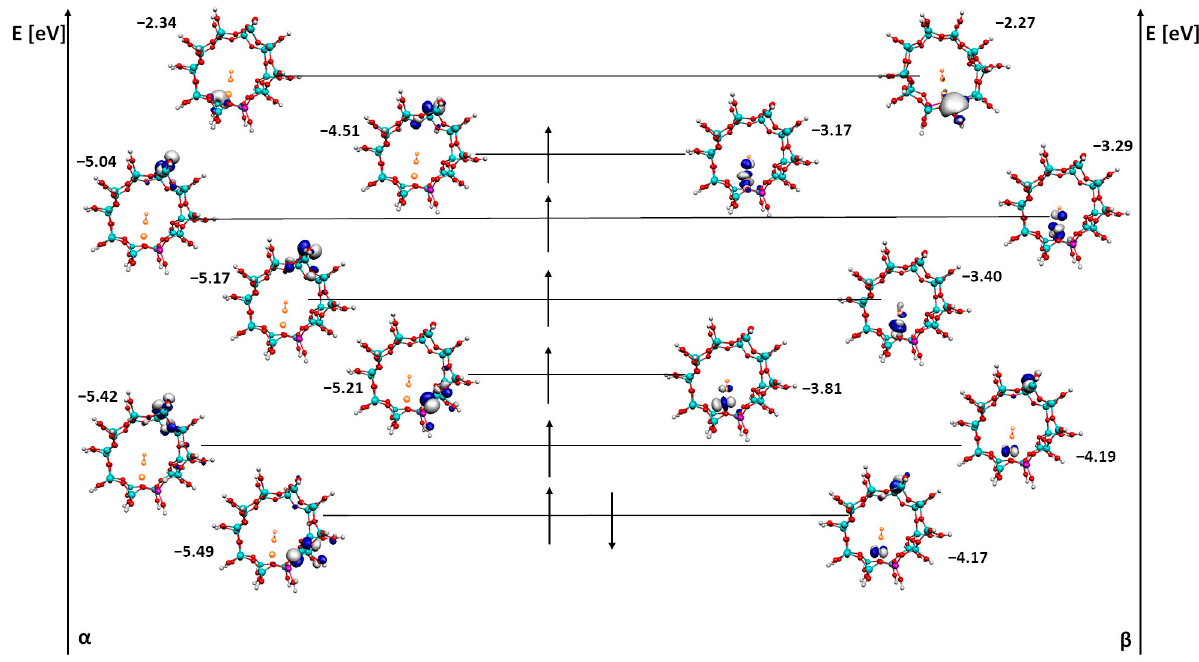
Figure 7. HOMO, SOMO and LUMO alpha and beta orbitals for ZSM-5 with FeOH adsorbed next to the active site. the active